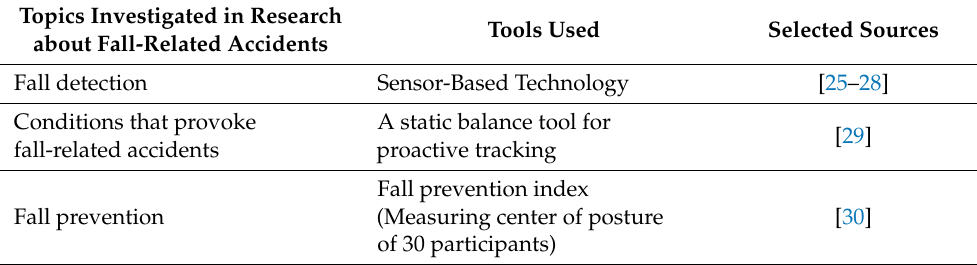
Table 1. Research about Fall-Related